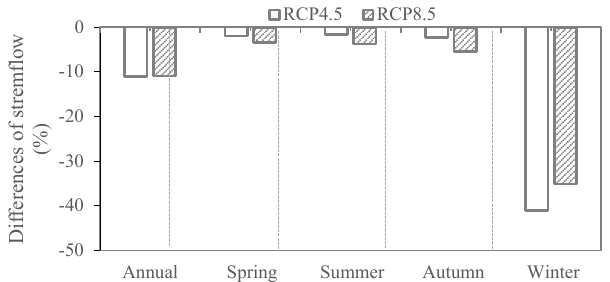
Figure 8. Projected changes of annual and seasonal streamflow (2021–2050) against to the base line period (1961–1990) for RCP4.5 and RCP8.5 in